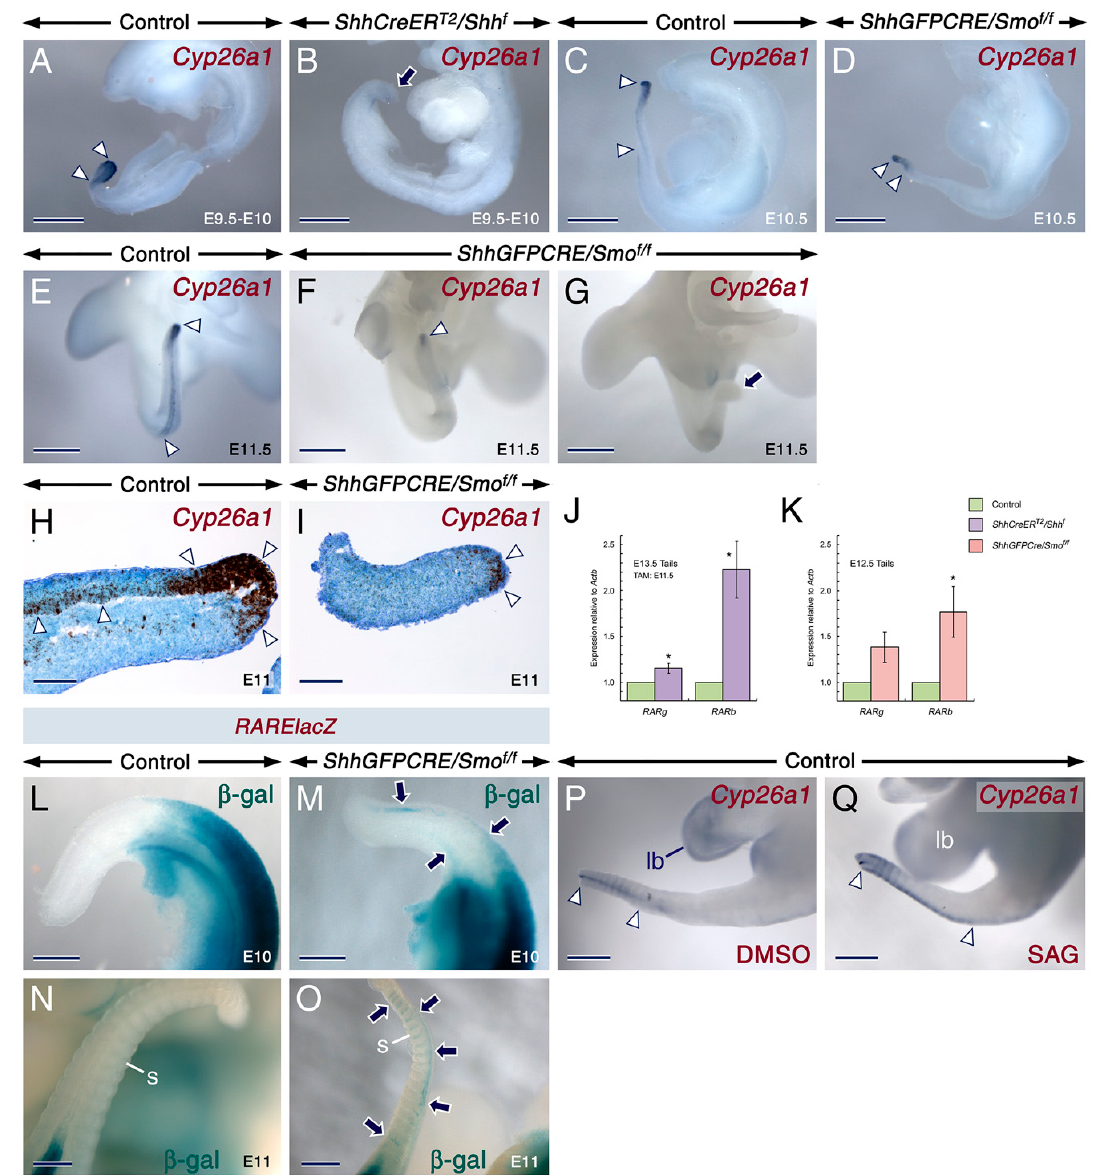
Figure 2. Loss of SHH signaling in the developing tail causes loss of Cyp26a1 expression and ectopic activation of retinoic acid signaling. ( A – G ) Representative whole-mount in situ hybridization (ISH) with riboprobes showing Cyp26a1 expression (purple) in developing tails. E9.5-E10 control ( A ; n = 3) and ShhCreER T2 / Shh f mutant ( B ; n = 4) embryos first exposed to tamoxifen (TAM) at E8-E8.5. Control ( C , E ) and ShhGFPCRE / Smo f / f mutant ( D , F , G ) embryos at E10.5 ( C , D ; n = 4 controls and n = 4 mutants) and E11.5 ( E – G ; n = 4 controls and n = 3 mutants). In the control tails, the Cyp26a1 expression domain extends from the tail bud to more rostral levels of the tail (arrowheads in A , C and E ). The mutant tails exhibit either a severely reduced domain of Cyp26a1 expression (arrowheads in D and F ) or abolished Cyp26a1 expression (arrows in B and G ). ( H , I ) Representative tail sections from E11 control embryos ( H ; n = 2) and a ShhGFPCRE / Smo f / f mutant embryo ( I ) after ISH for Cyp26a1 with oligonucleotide probes (black). Decreased Cyp26a hybridization signals in the mutant tail as compared to the control tail (arrowheads in H and I ). ( J , K ) RT-qPCR analysis showing the expression levels of RARb and RARg relative to Actb ( β -actin). Upregulation of RARb ( p = 0.0162) and RARg ( p = 0.0261) levels in tails from E13.5 ShhCreER T2 / Shh f mutant ( n = 3 and n = 4 for RARb and RARg analyses, respectively) as compared to tails from control ( n = 3 and n = 4 for RARb and RARb analyses, respectively) embryos first exposed to TAM at E11.5 ( J ). Upregulation of RARb ( p = 0.0476) and RARg ( p = 0.0610) levels in tails from